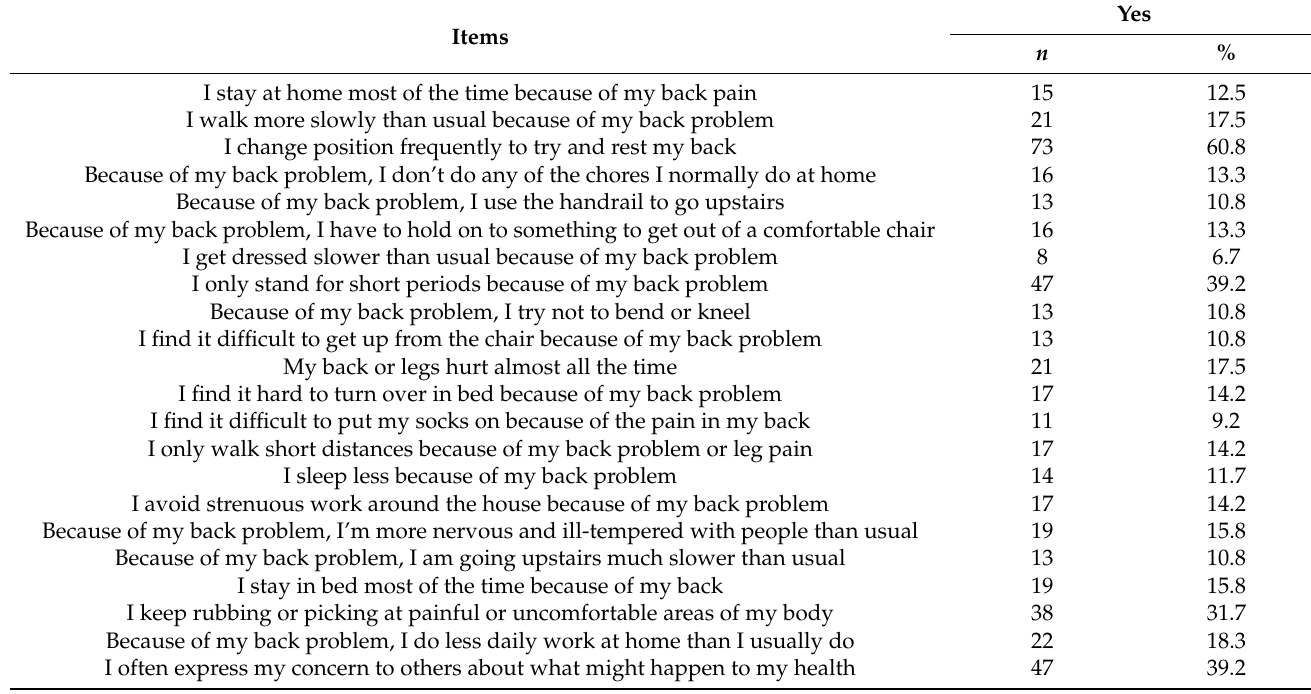
Table 4. Number and distribution student functional limitation due to low back pain.